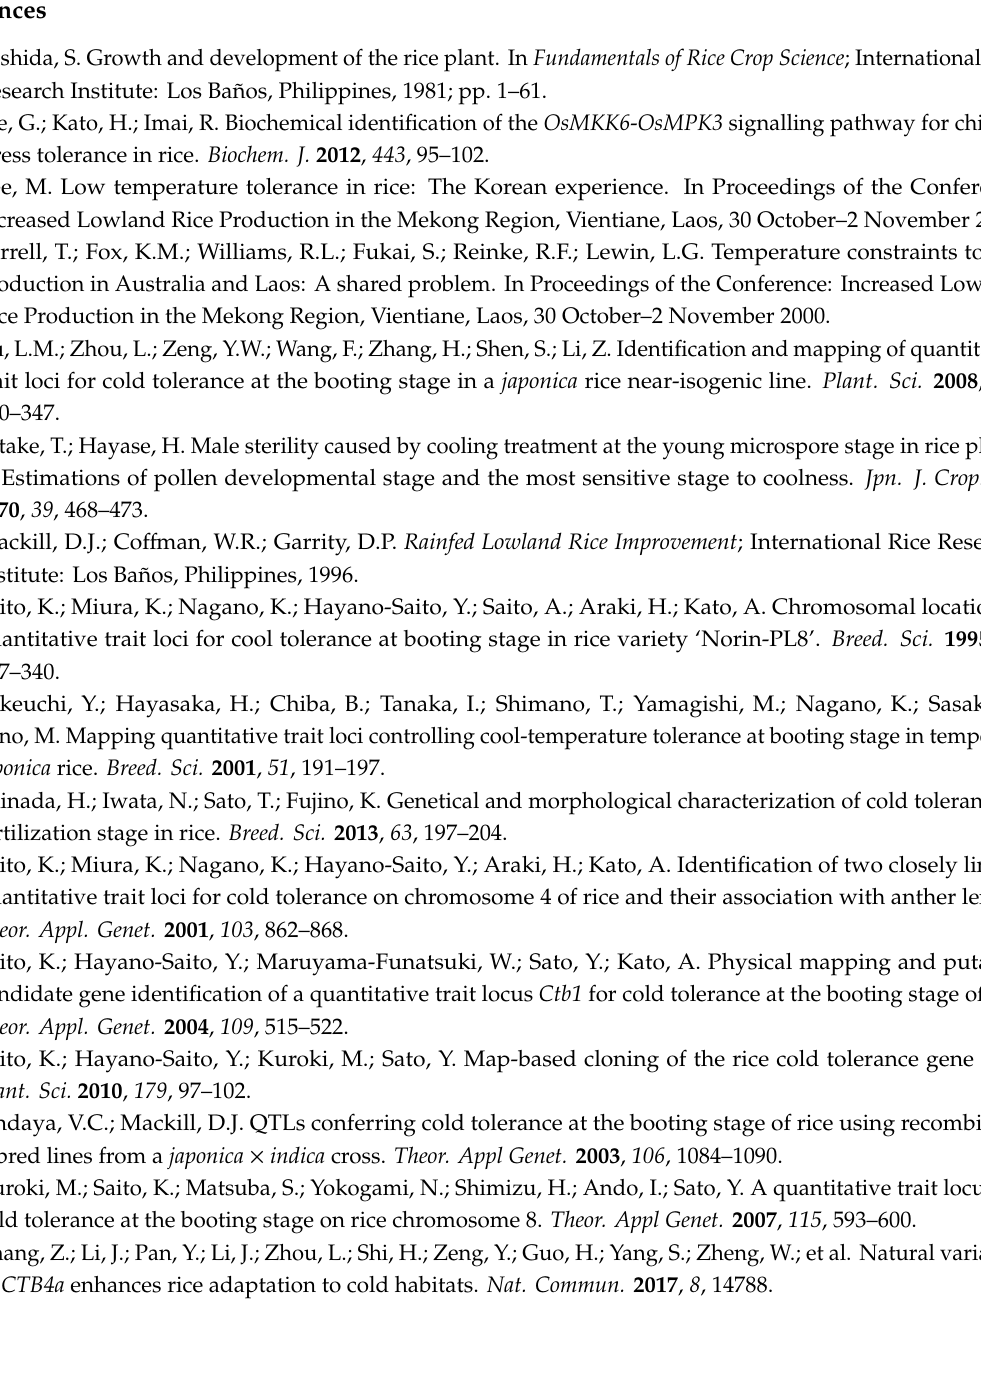
Figure S1: Linkage map from the Milyang23 × Giho RIL population using 168 SSR and 159 SNP markers, Table S1: QTL for spikelet fertility and other agronomic traits under control